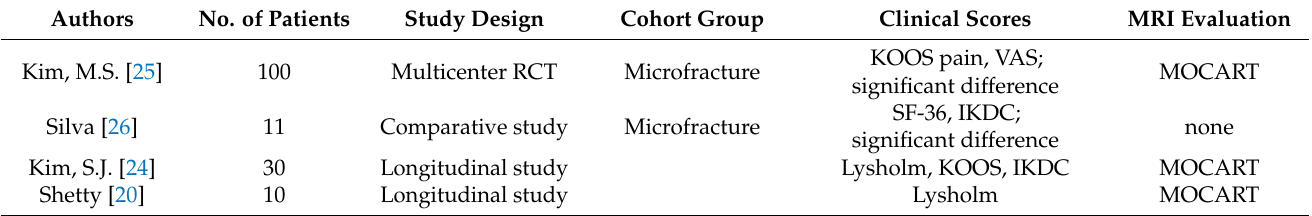
Table 1. Summary of clinical studies on ACIC for knee chondral